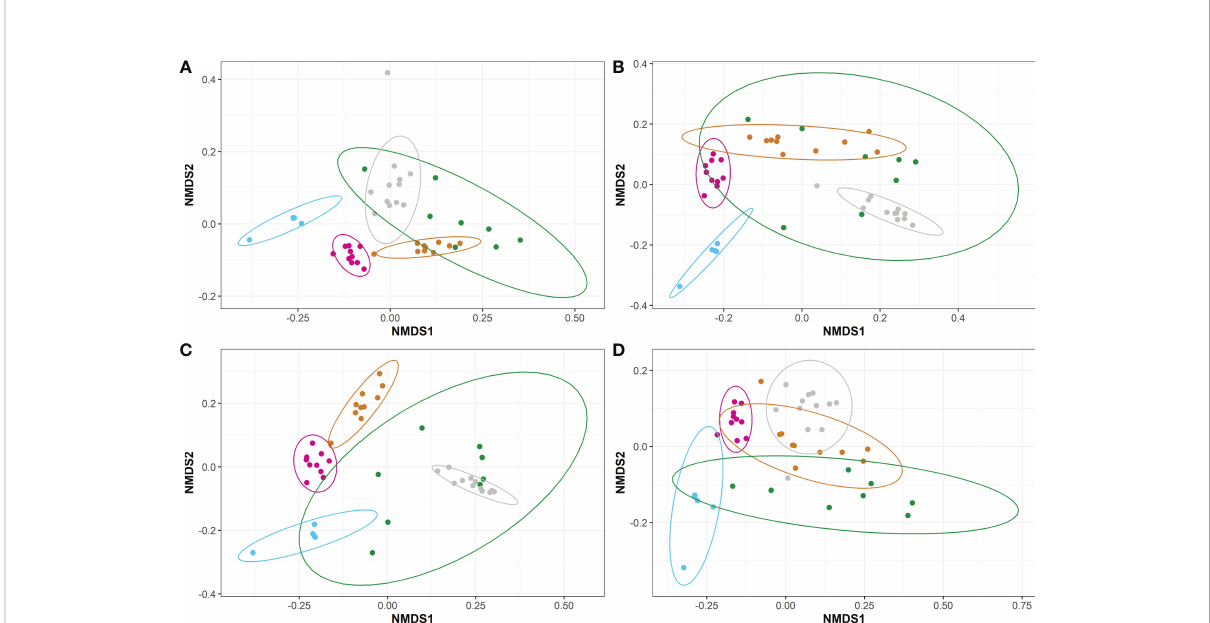
FIGURE 5 Non-metric Multidimensional Scaling (NMDS) plots representing the weighted beta diversities of steelhead trout bacterial microbiomes for the duration of a probiotic feeding regime. Distances were calculated by weighted UniFrac between the fi ve timepoints for fi sh fed diets (A) A, (B) B, (C) C, and (D) D. Timepoints are represented by the colors cyan (T-1), maroon (T0), orange (T1), green (T2), and gray (T3). Ellipses represent the 95% con fi dence intervals calculated via Student ’ s T test for fi ve non-disinfected eggs, 10 T0 internal homogenates, 10 T1 internal homogenates, eight T2 intestinal homogenates, and 12 T3 intestinal